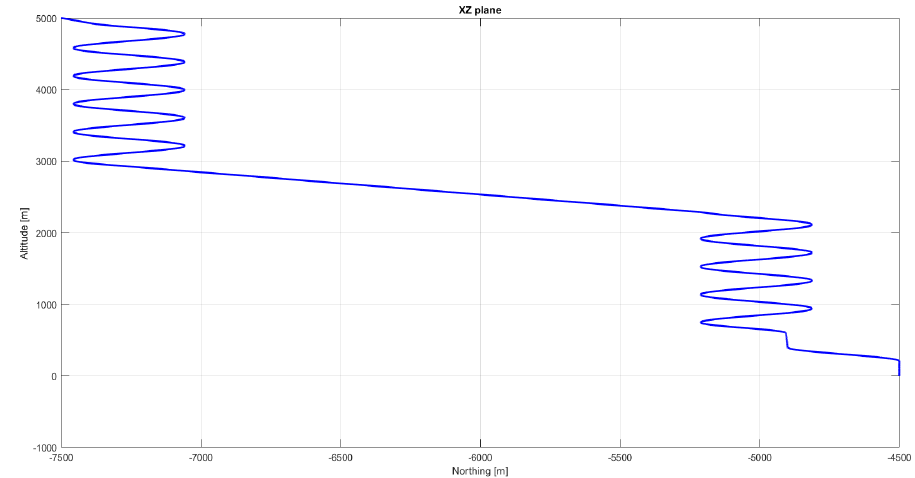
Figure 13. Guidance trajectory view in the xz − plane.